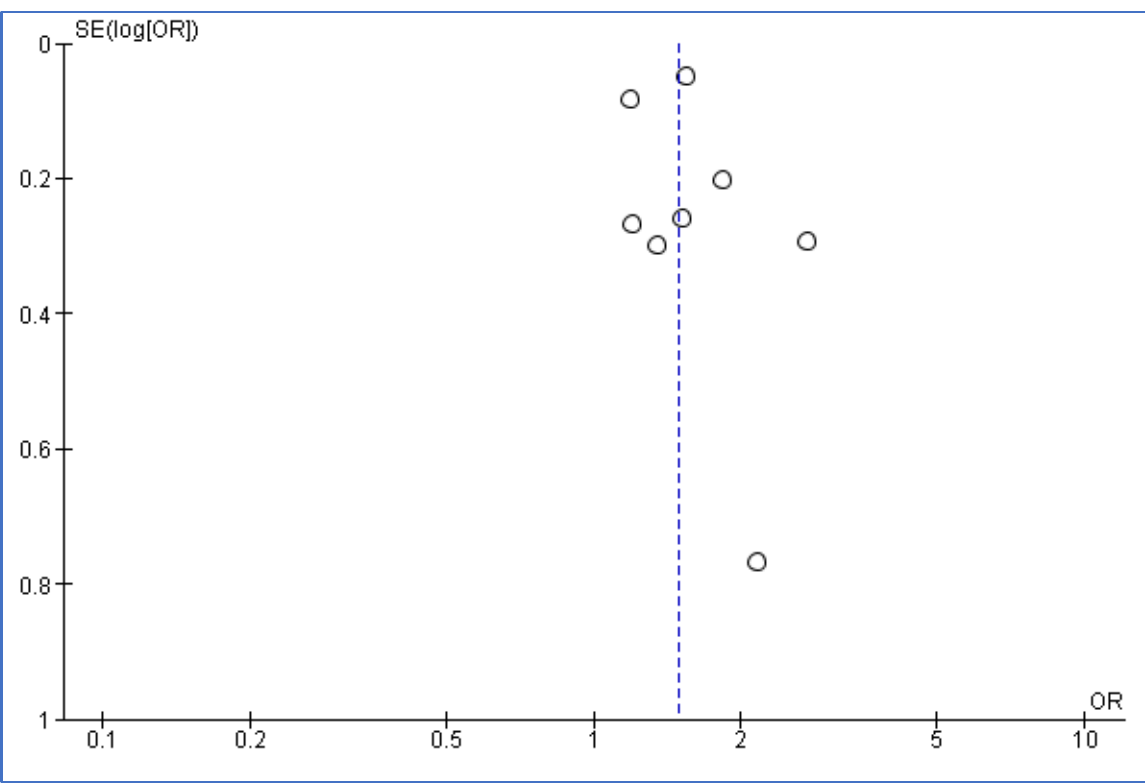
Figure 4. Funnel plot to explore publication bias.